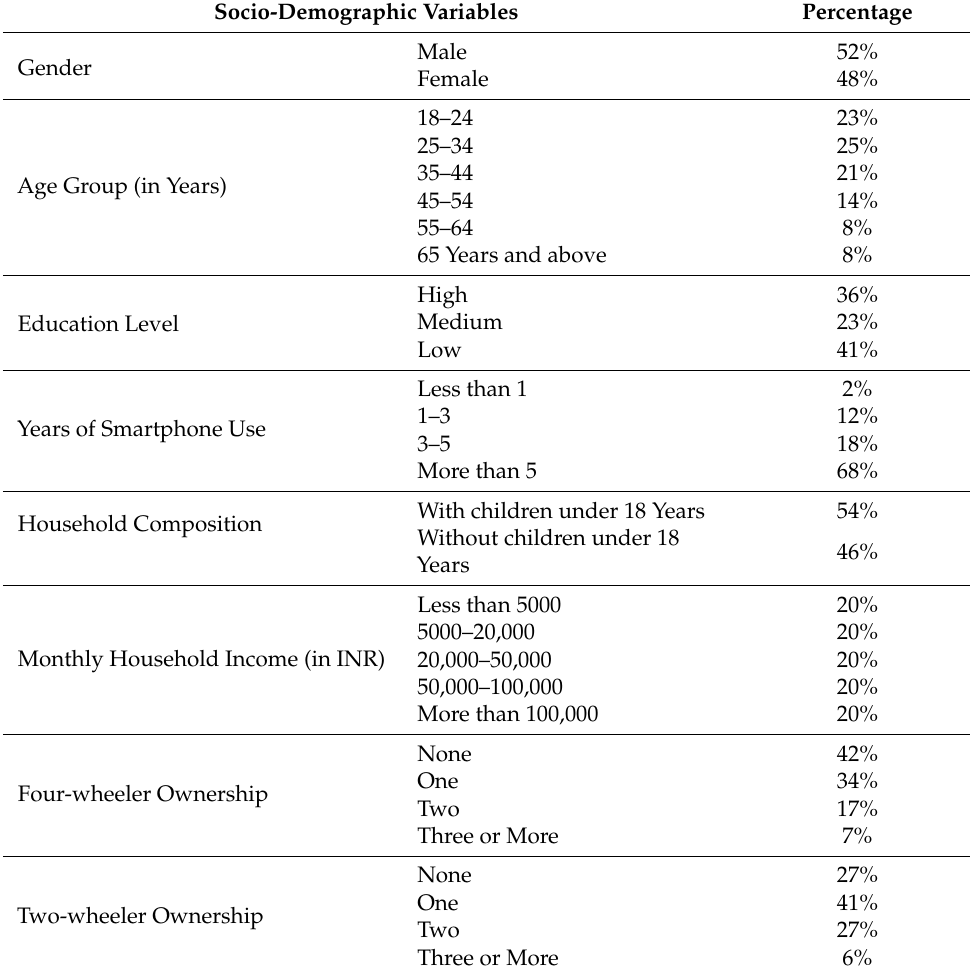
Table 2. Socio-Demographic distribution of the selected survey